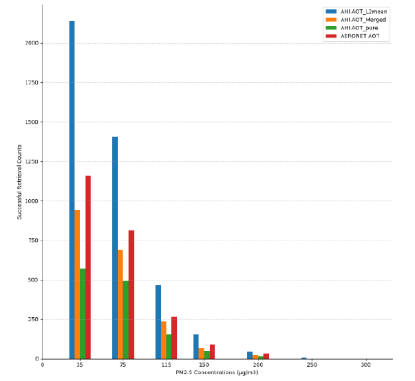
Figure 5. retrieval number histogram of AHI hourly AOTs and ground AOT under the condition of different PM2.5 concentration